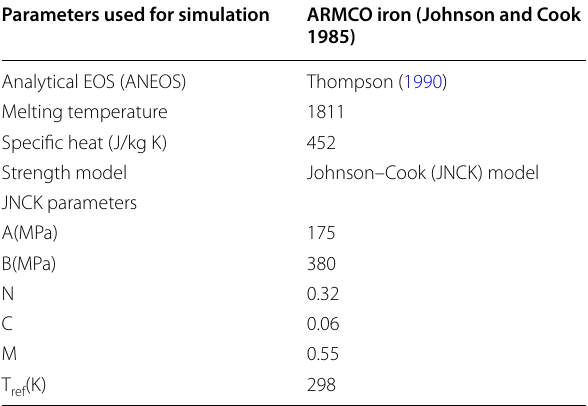
Table 4 Calculation settings used in the numerical simulations with the